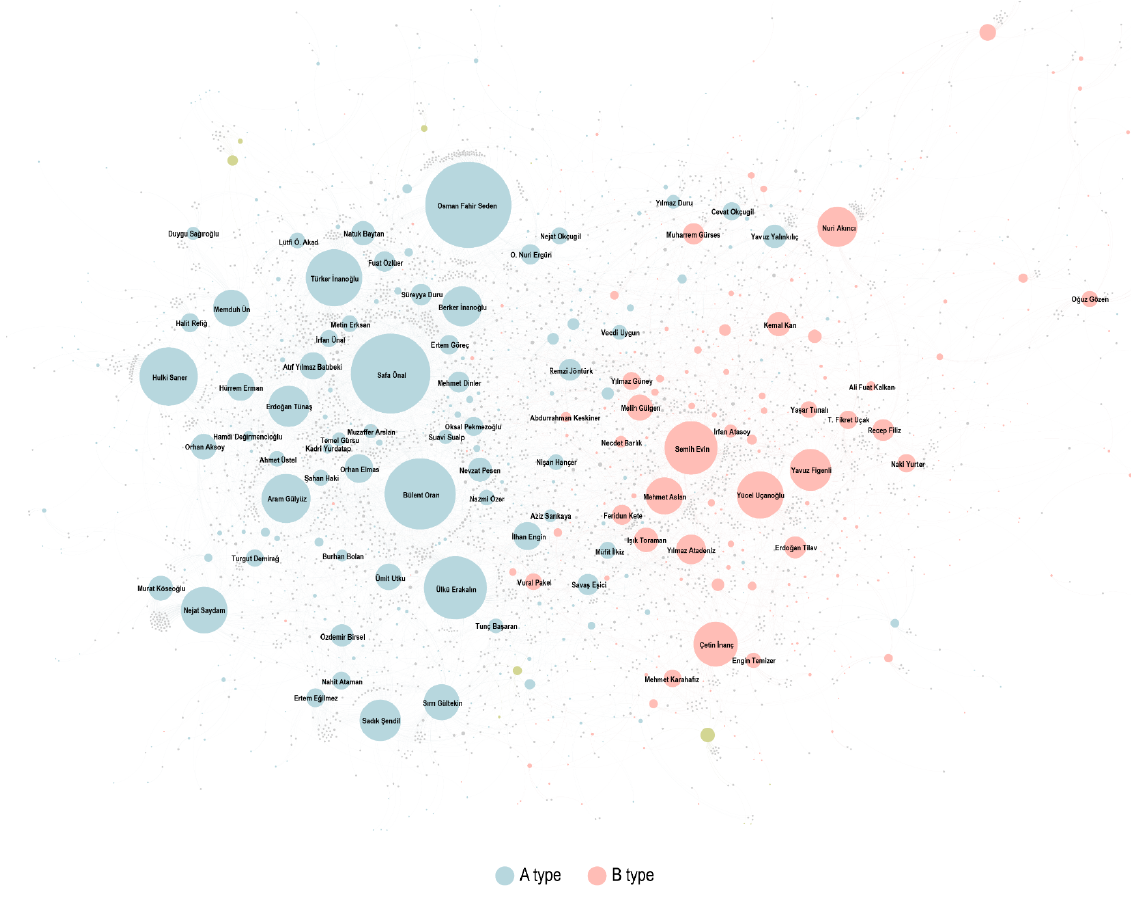
Figure 1. Players of the Yeşilçam film industry and their subnetworks (1960-1979). Colored nodes represent the players, while grays are the films, and edges indicate relations between players and films. Node size is proportional to weighted degree. Modularity with resolution: